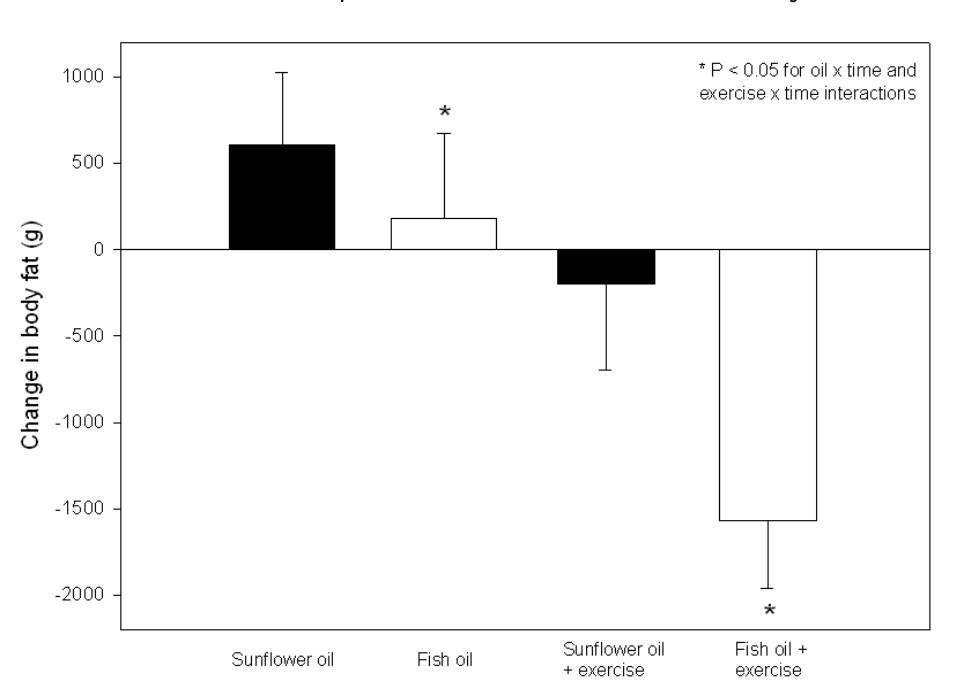
Figure 1. Dual-energy X-ray absorptiometry assessed changes in body fat mass after supplementation with 6 g/day of docosahexaenoic acid-rich fish oil, 6 g/day sunflower oil, fish oil and exercise or sunflower oil and exercise for 12 weeks in overweight and obese adults. * Significant oil × time and exercise × time interactions were detected ( P < 0.05). Adapted from Hill et al. [33] with permission from the American Society for